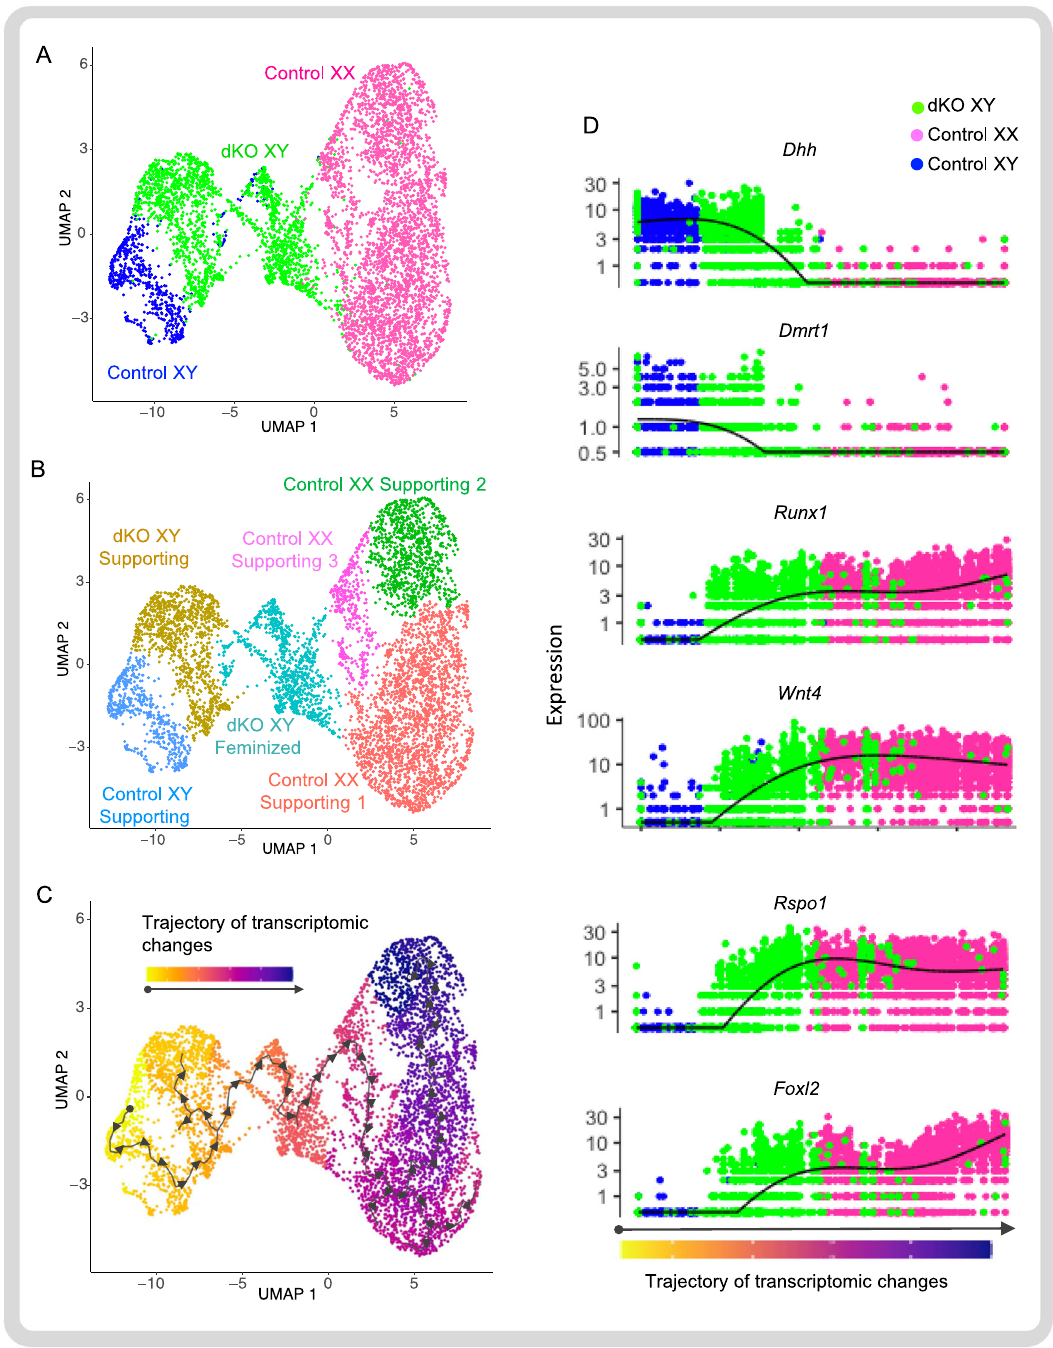
Fig. 4 Feminization of the dKO XY supporting cells at the single cell level. A Single cell mRNA sequencing analysis and clustering of the supporting cells based on their genotypes: control XY (blue), dKO XY (green), and control XX (pink) gonads at E15.5. Each dot represents the transcriptome of a single cell. B Cell clustering based on their unique transcriptomes: one population in the XY control, two subpopulations in the dKO XY, and three subpopulations in the control XX supporting cell populations. C Trajectory of transcriptomic changes (pseudotime analysis) among supporting cells. Control XY supporting cell in the far left was arbitrarily designated as the starting point (black dot) of the differentiation. Arrows and the gradient of colors (yellow to dark blue) indicate the direction and progression of transcriptomic changes. D Transcriptome trajectory of six representative genes critical for sex determination of the XY gonads ( Dhh and Dmrt1 ) and XX gonads ( Runx1 , Wnt4 , Rspo1 , and Foxl2 ). The X axis represents the arbitrary trajectory of transcriptome changes from a single control XY supporting cells toward control XX supporting cells (dark blue). Y axis indicates the gene expression level in each cell. The black lines represent the average expression of the genes over the progression. Source data are provided as a Source Data fi le. N = 2 biologically independent samples per